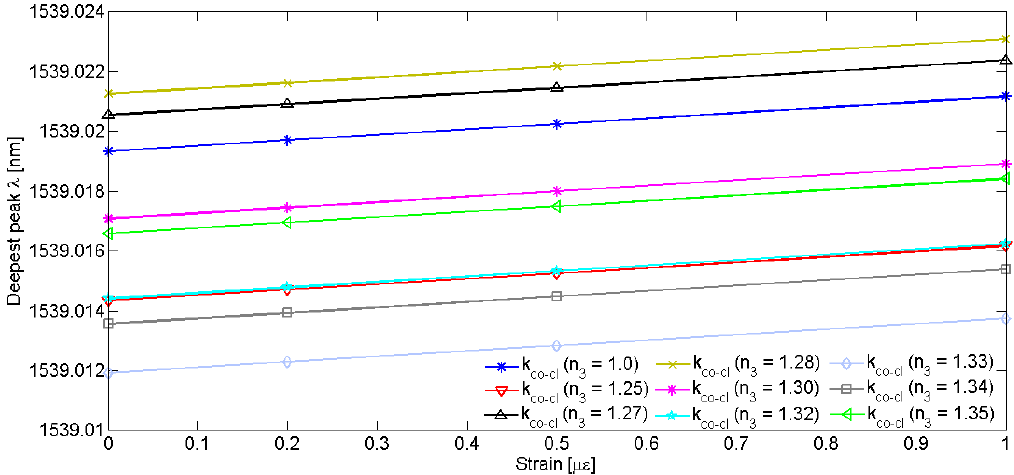
Figure 10. Wavelength shift of the deepest splitting resonance when various strains, ranging from 0 µ ɛ to 1 µ ɛ , are applied to an LPGRR with different core-to-cladding coupling coefficients. Table 5. Optical and fitting parameters as a function of cover RI variations.